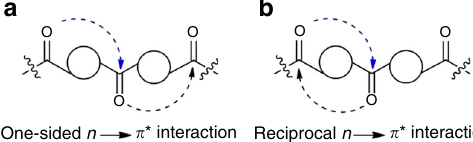
Fig. 1 Schematic illustration of a one-sided and b reciprocal n → π * interactions. Curved dotted arrows indicate n → π *